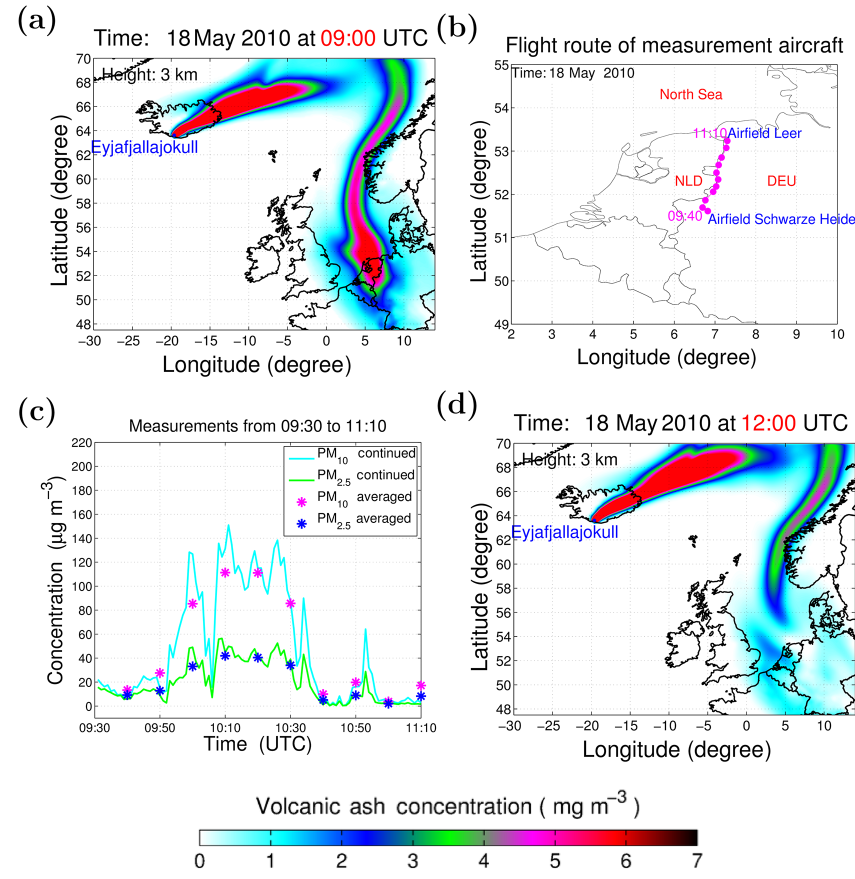
Figure 1. Methodology of ensemble-based DA. (a) The initial volcanic ash state at 09:00UTC. (b) Flight route of measurement aircraft. (c) Aircraft in situ measurements of PM 10 and PM 2 . 5 from 09:30 to 11:10UTC, 18 May 2010. (d) Volcanic ash assimilation result at